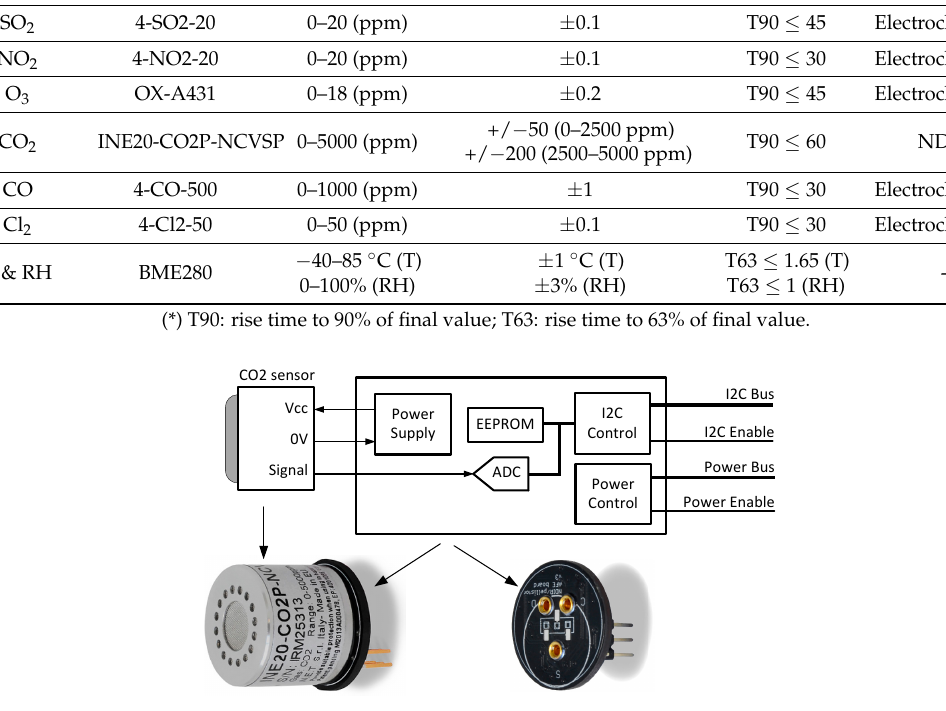
Figure 3. NDIR-type CO 2 sensor and its interface module.